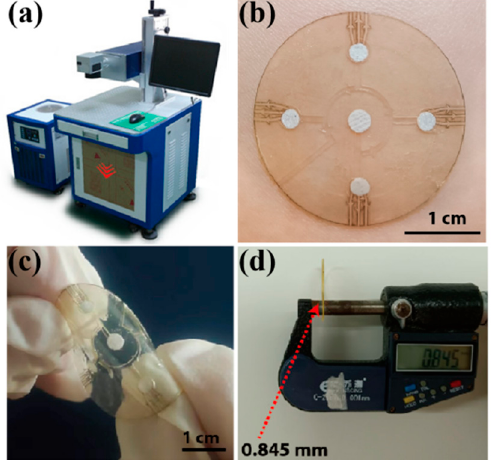
Figure 4. ( a ) The laser-cutting system for microfluidic patch preparation. ( b ) A physical picture of the microfluidic patch on a volunteer’s forearm. The patch is flexible ( c ) and thin, with a thickness of about 0.85 mm ( d ).